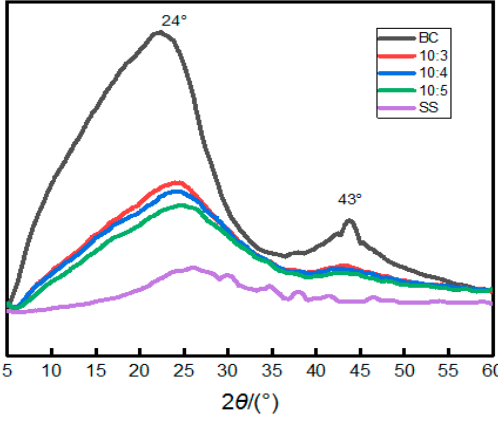
Figure 5. XRD patterns of the BC/SS composites with different mass ratios.